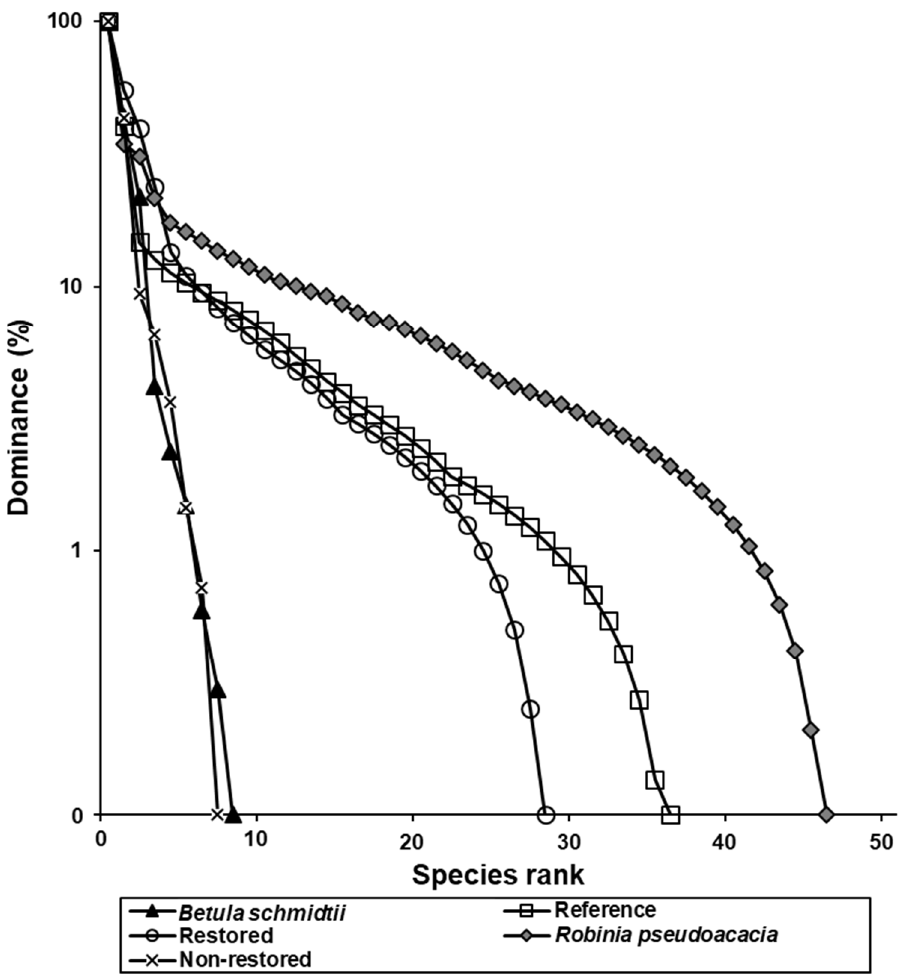
Figure 8. Rank–abundance curves of vegetation including sites restored ecologically (restoration), rehabilitated applying silvicultural method ( Betula schmidtii and Robinia pseudoacacia ), and reference stands dominated by Pinus densiflora.